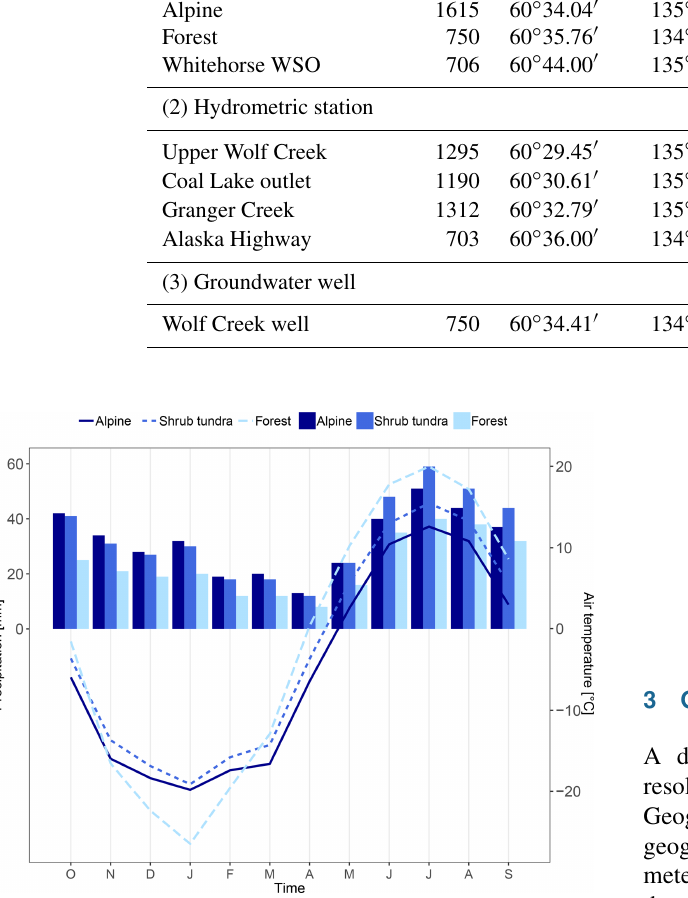
Figure 2. Monthly precipitation and air temperatures at the three sites in Wolf Creek Research Basin averaged over the period of